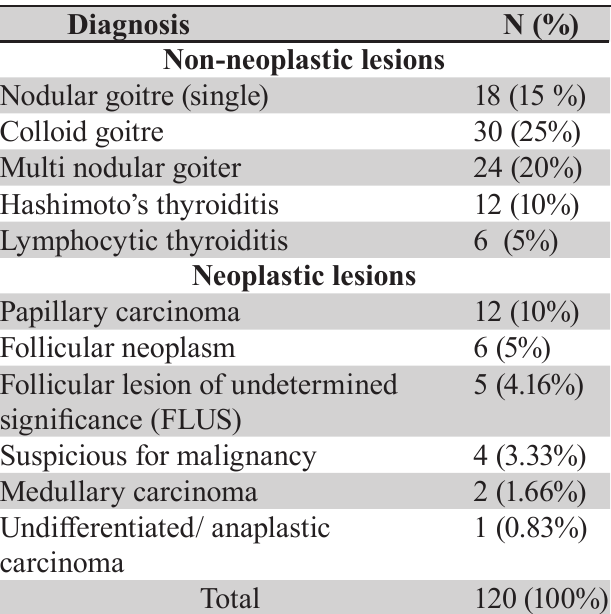
Table 2. Frequency of various thyroid lesions on cytology (N=120).